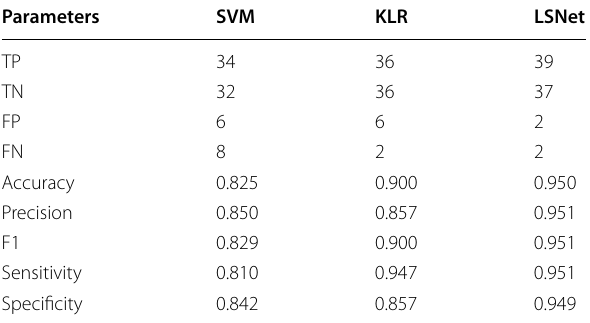
Table 7 Calculation results of statistical indexes for landslide